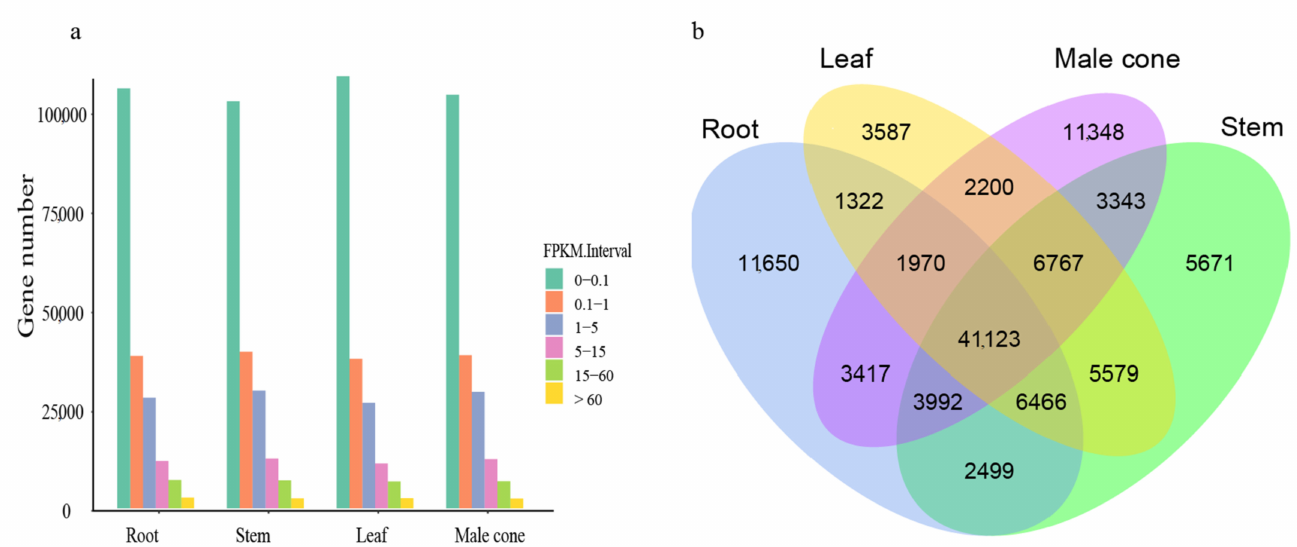
Figure 3. Analysis of gene expression in four tissues of C. oliveri . ( a ) The fragments per kilobase of transcript sequence per million base pairs sequenced (FPKM) interval distribution in four tissues; ( b ) A Venn diagram of the number of unigenes expressed in four tissues.